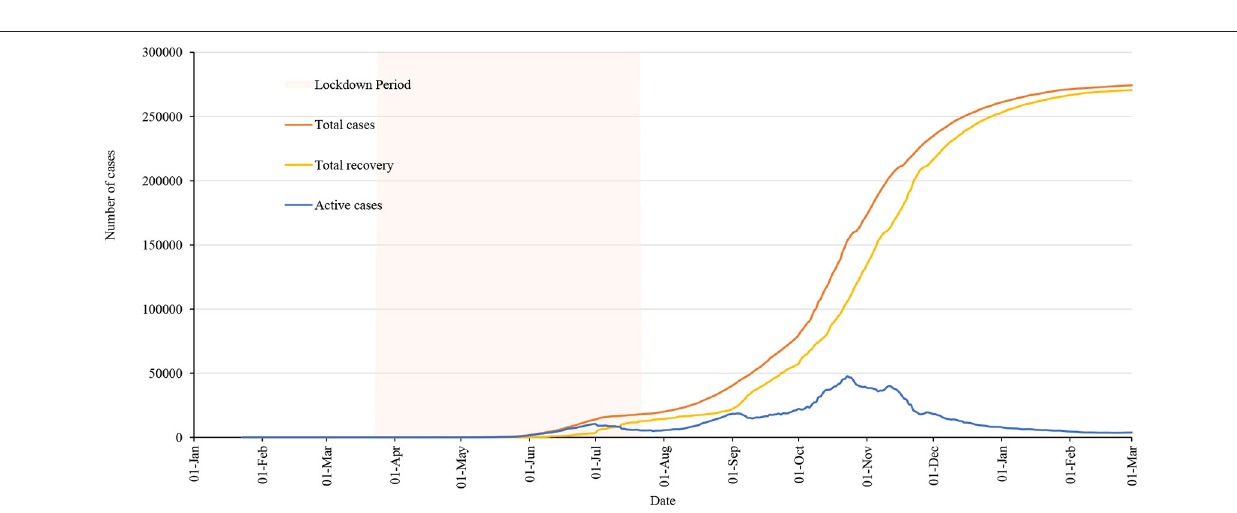
Frontiers in Public Health |